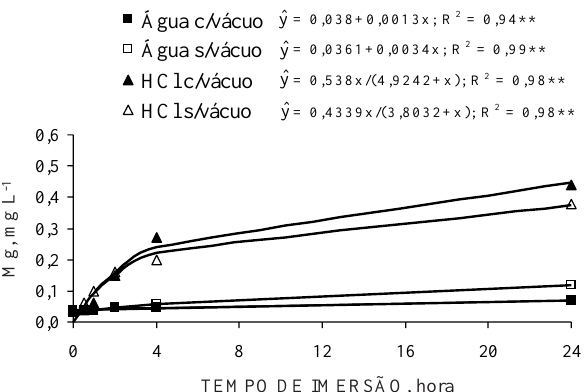
Figura 3. Teor de magnésio da água de imersão das cápsulas, considerando o tempo de